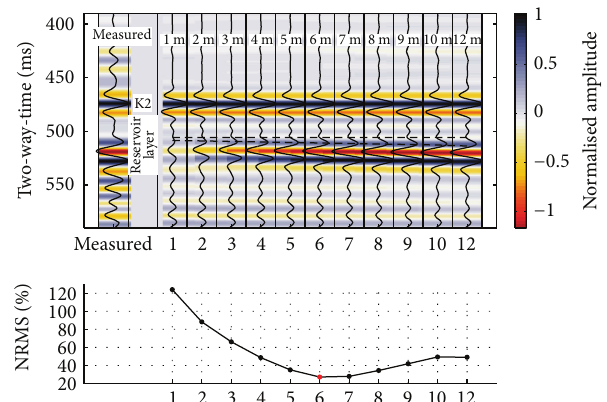
Figure 10: Result of wedge modelling for the 10–20–80–100 Hz bandpass filtered data. Top: the corridor-stacked trace of the measured repeat is plotted on the left side. The coloured amplitudes are overlain by the wiggle trace. On the right, the result of wedge modelling is shown, from left to right for 1m to 12m reservoir thickness. The top and bottom of the reservoir are plotted as dashed black lines. Bottom: NRMS error between the modelled and measured